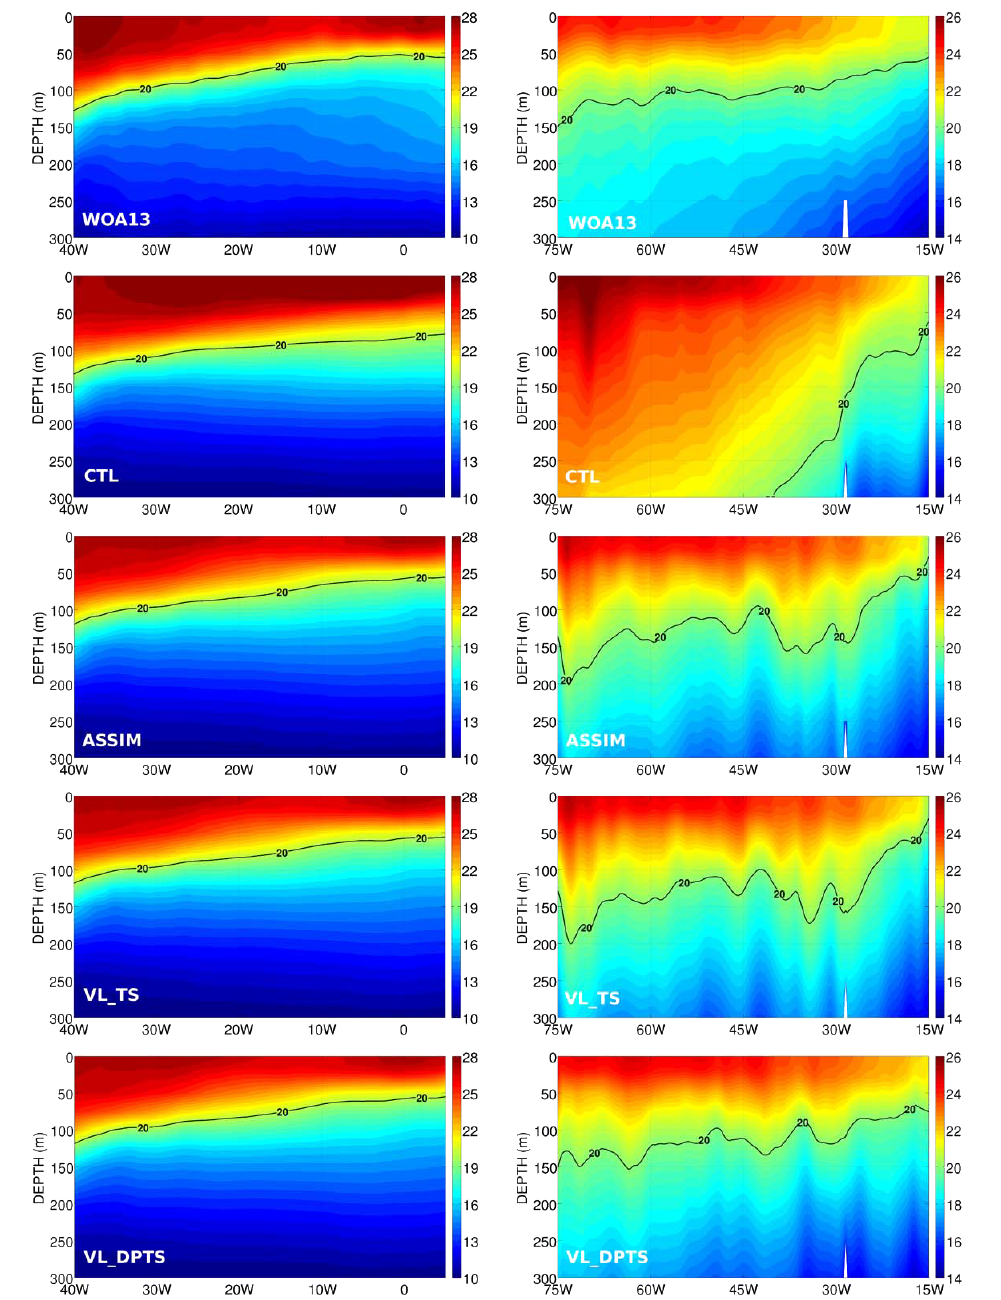
Figure 7. Temperature ( ◦ C) along the Equator (left) and along 30 ◦ N (right) in the upper 300m for the WOA13 climatology, the CTL run and the prior state of the ASSIM, VL_TS and VL_DPTS runs from 1 January 2010 to 31 December